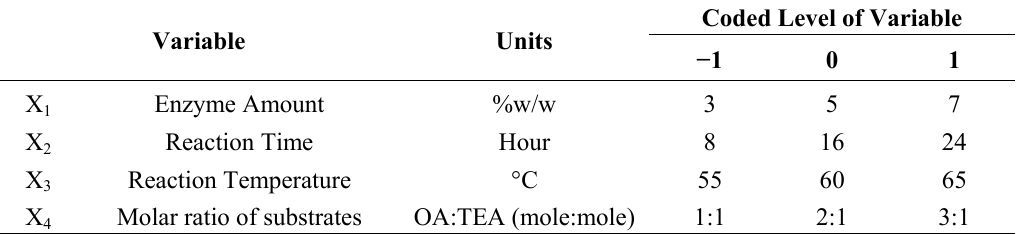
Table 6. Variables and their levels employed in the Taguchi robust design method. Coded Level of Variable Units